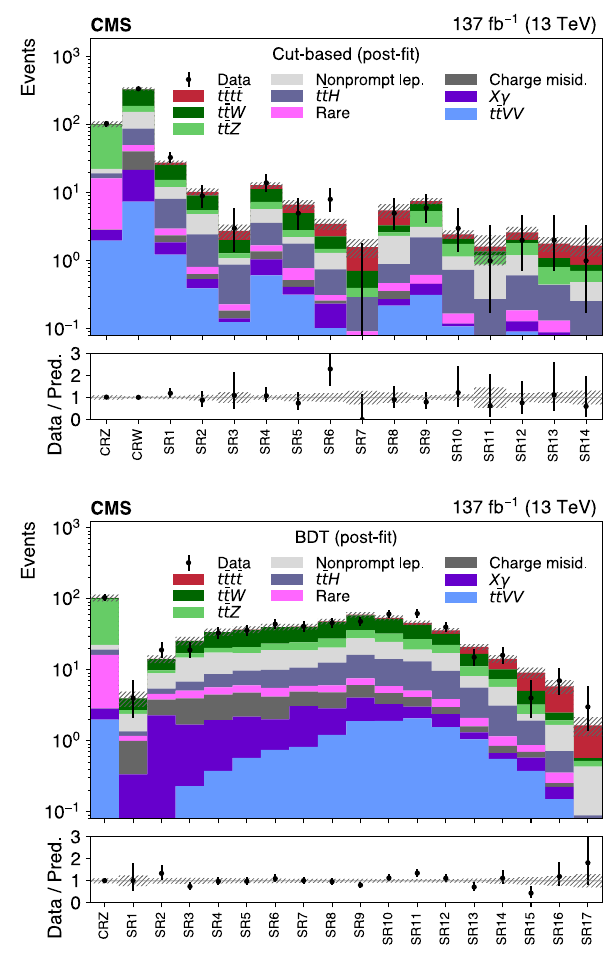
Fig. 4 Observed yields in the control and signal regions for the cut- based (upper) and BDT (lower) analyses, compared to the post-fit pre- dictions for signal and background processes. The hatched areas repre- sent the total post-fit uncertainties in the signal and background predic- tions. The lower panels show the ratios of the observed event yield to the total prediction of signal plus